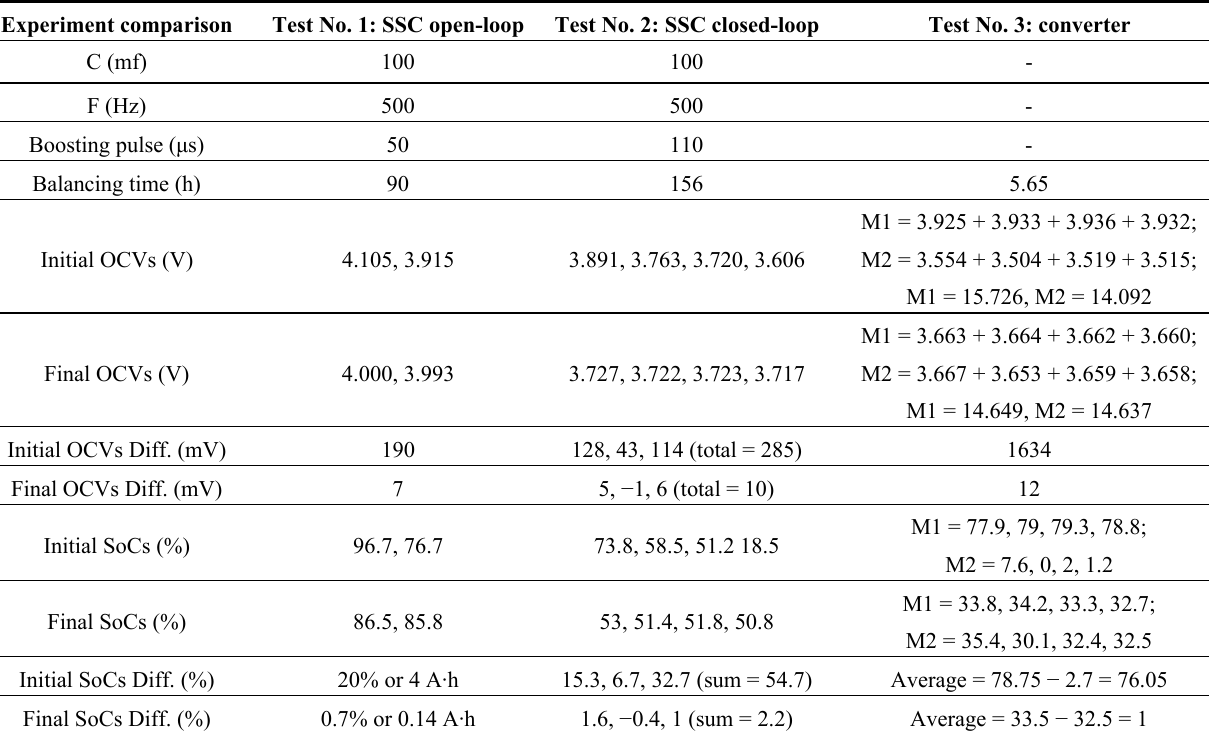
Table 4. Experimental balancing tests results, 20 A·h using SSC with boosting technique and isolated bidirectional DC/DC converter